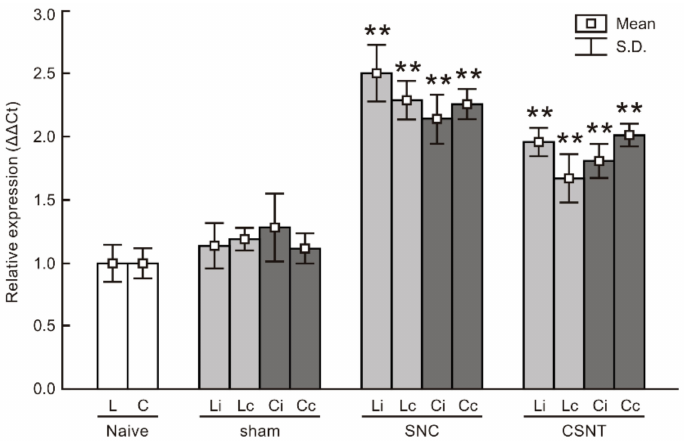
Figure 6. Results of real-time PCR (RT-PCR) of relative TLR9 mRNA levels in DRG of lumbar (L) and cervical (C) spinal segments from ipsilateral (i) and contralateral (c) sides of naive as well as sham-, SNC- and CSNT-operated rats for 7 days ( n = 6 for each group). Relative expressions were determined using actin as the housekeeping gene and normalized to naive controls. ** Significant difference ( p < 0.01) compared with naive or sham-operated rats in a Kruskal–Wallis ANOVA